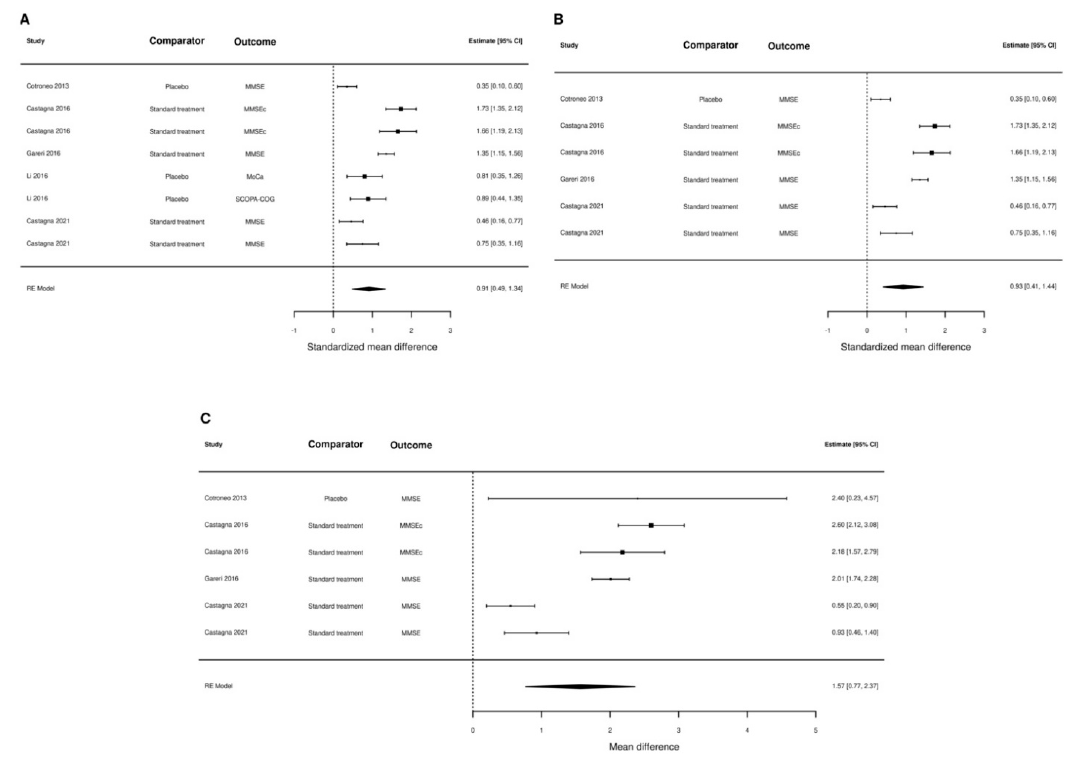
Figure 3. Forest plot summarizing all studies (panel ( A )), only observational studies (panel ( B )), and only studies using MMSE as outcome measure (panel ( C )). SD were calculated assuming a large correlation coefficient (r = 0.9). Table 4. GRADE framework (grading of recommendations, assessment and evaluation).